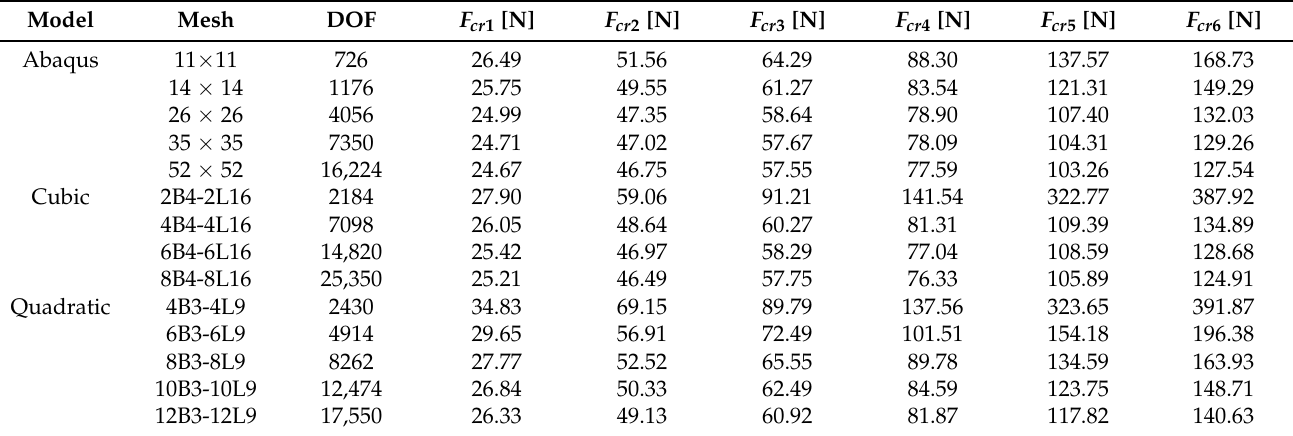
Table 4. Convergence of the buckling load for the Case 2 pristine structure. A uniform fibre volume V f = 0.60 is considered and no fibre waviness.